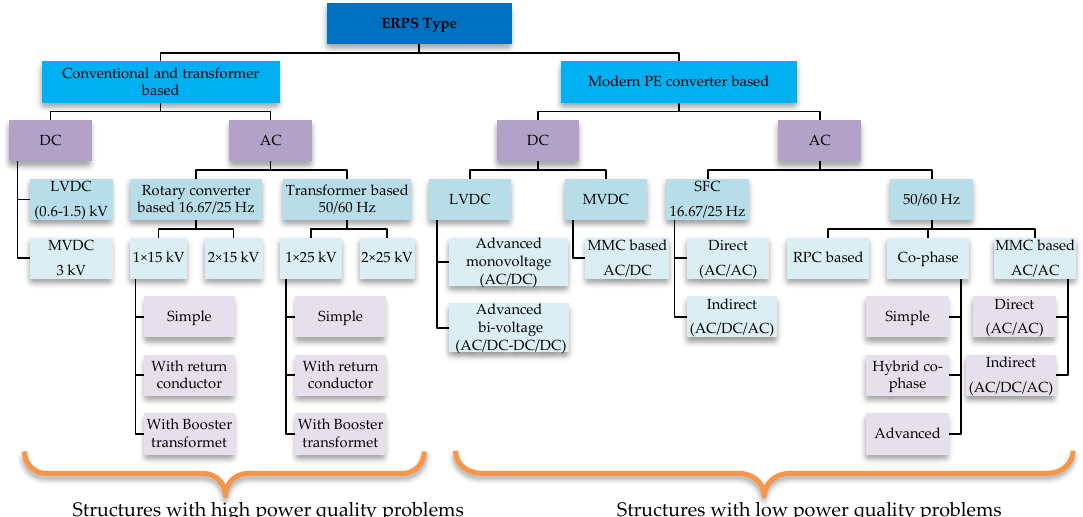
Figure 27. Classification and organization chart of different ERPS configuration.